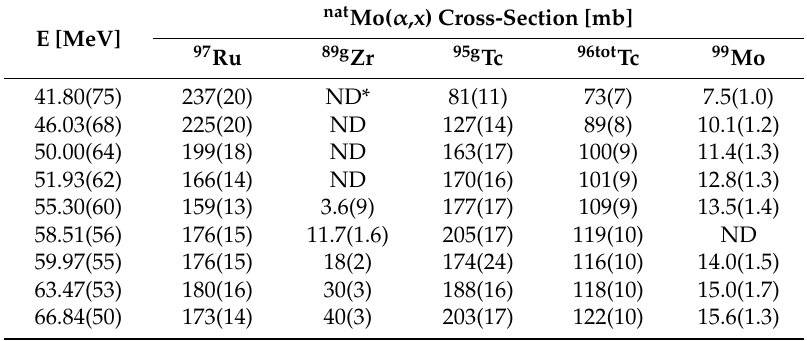
Table 2. Measured cross-sections for nat Mo( α ,x) reactions (with the uncertainties in the parenthesis). nat Mo( α ,x) Cross-Section [mb] E [MeV] 97